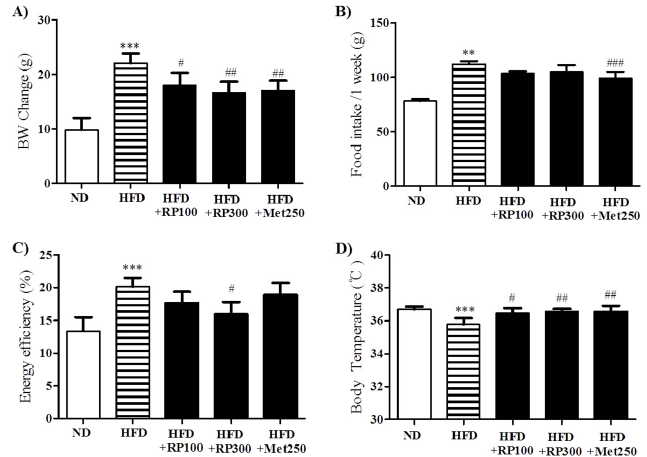
Figure 2. Effects of RP extract on body weight. ( A ) Body weight; ( B ) Food intake; ( C ) Energy efficiency rate; and ( D ) Body temperature were measured in C5BL/6 mice during the 16 ‐ week study period. Results are presented as means ± standard errors of the mean (SEM) ( n = 5). *** p < 0.001 and ** p < 0.01 versus the normal chow fed controls (ND group); ### p < 0.001, ## p < 0.01, # p < 0.05 vs. the HFD mice. RP, Radix Pueraria lobata ; ND, normal diet; HFD, high fat diet; BW, body